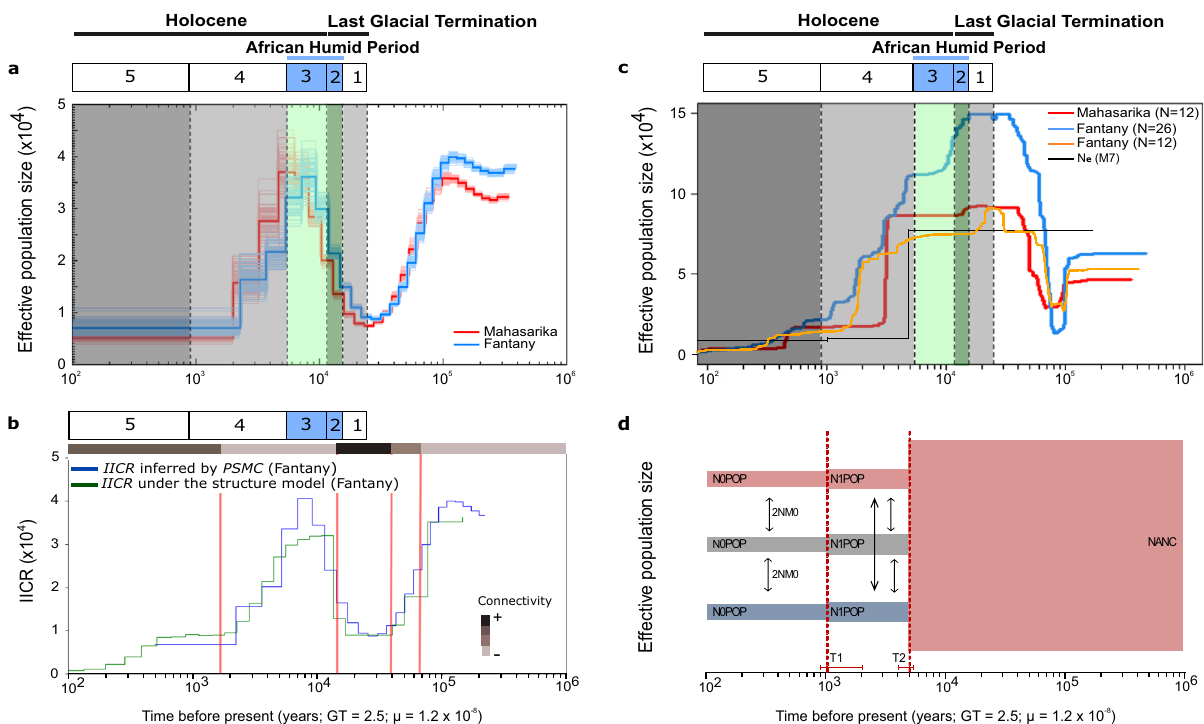
Fig. 3 Integration of the four complementary demographic approaches used in this study. a Inference of the demographic history of M. arnholdi with the PSMC method. The thick red and blue lines represent the inferred trajectories of the northern (Mahasarika) and the southern (Fantany) site. Each light line represents 100 subsampled bootstrap replicates for each individual. The legend on the top identi fi es the fi ve periods of environmental change derived from the paleoenvironmental reconstructions de fi ned in the text. b IICR inferred by the PSMC method for Fantany (blue) and IICR under an n-island model of migration considering a constant population size and four changes in population connectivity (green). Vertical red lines mark the times of change in connectivity (~65, ~40, ~10 − 15 and ~1 – 2 kyr). Horizontal bars on top in gray shades indicate relative levels of connectivity (see Supplementary section 2.1.9 and Fig. S6 for details about the connectivity inferences). c Demographic history inferred for Mahasarika (red, N = 12) and Fantany (blue, N = 26) with the Stairway Plot method. The demographic dynamics of Fantany were repeated considering an equal sample size as for Mahasarika (orange, N = 12). For reasons of direct comparison, the black line illustrates the effective population-size dynamics as suggested by the best- fi tting demographic model (M7) by fastsimcoal2 over time. d Illustration of the best demographic model (M7) revealed by fastsimcoal2 . The model suggests the occurrence of two consecutive population declines during the last 5 kyr. The different populations are represented by distinct colors. An additional population ( “ ghost population ” ) was included to represent intermittent M. arnholdi sampling sites that were not covered by our sampling scheme. The width of bars is proportional to the estimated effective population size ( N e , details in Table 1). The occurrence of gene fl ow is exempli fi ed by arrows. N0POP = effective population size for each population at present time; N1POP = effective population size for each population after the fi rst population decline; NANC = ancestral population size; 2NM0 = average number of haploid immigrants entering the population per generation. T1 = time of the younger population decline; T2 = time of the older population decline. Horizontal error margins represent the 95% con fi dence intervals for the time of the population declines. Parameter estimates are summarized in Table 1. All analyses were performed considering 2.5 years as generation time. See also Supplementary section 2.2.4 and Figs. S13 – S16 for demographic inferences considering a generation time of 1.0 and 4.5 framework implemented in fastsimcoal2 20 . The models incorpo- rated various combinations of changes in population size,